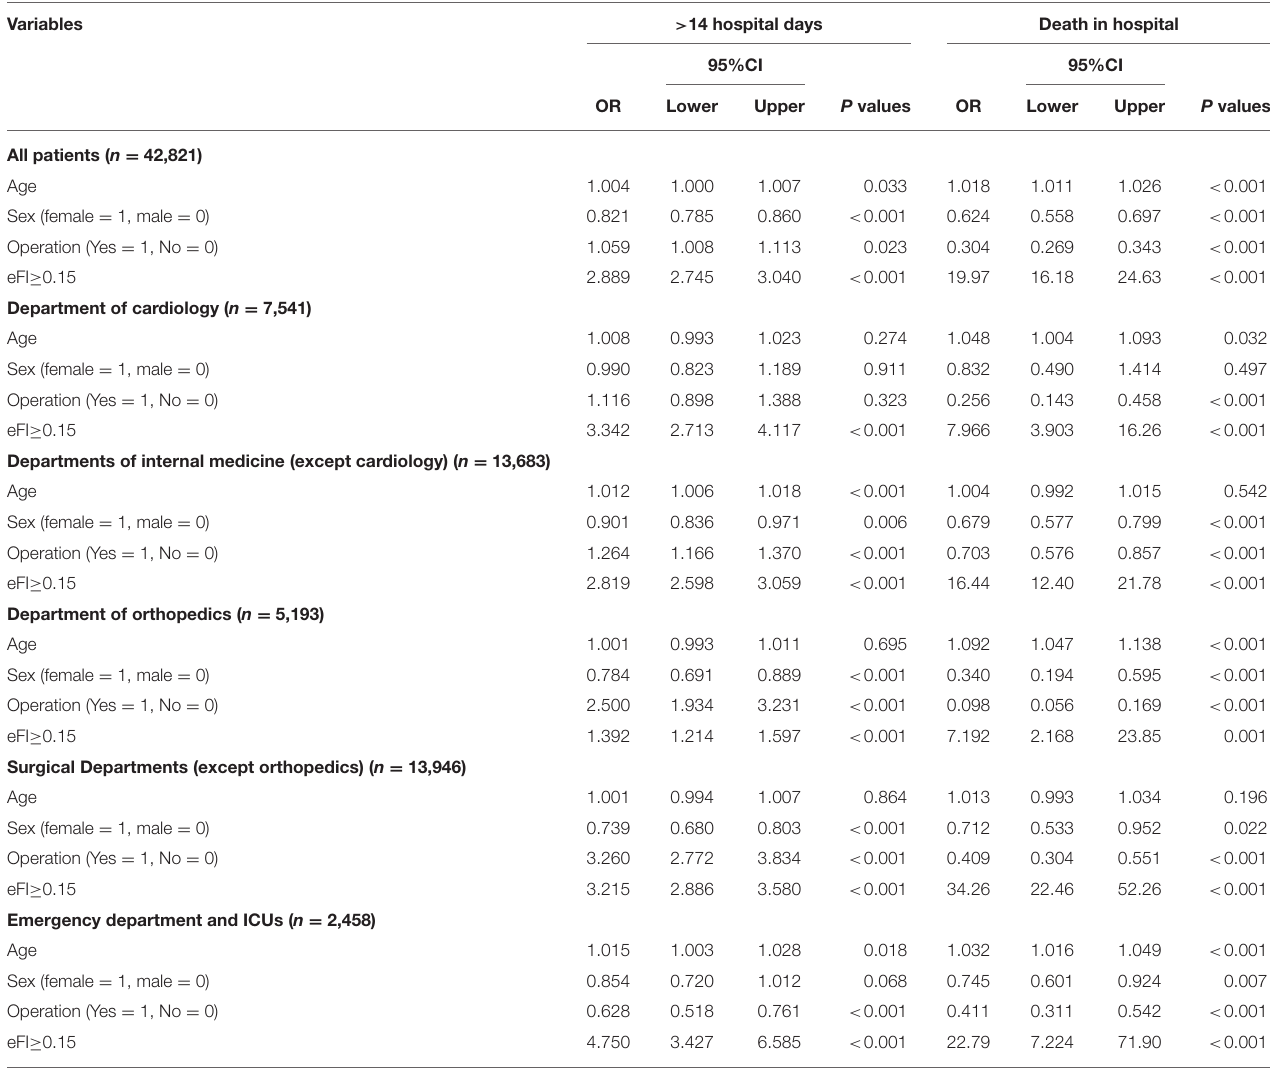
TABLE 3 | Association between eFI and hospitalized events of elderly inpatients by logistic regression.